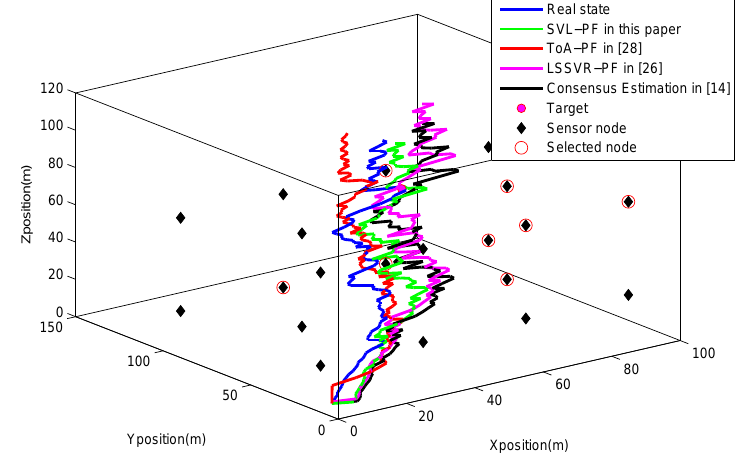
Figure 4. The localization trajectory of the proposed algorithm and the compared algorithms in the universal noise condition.